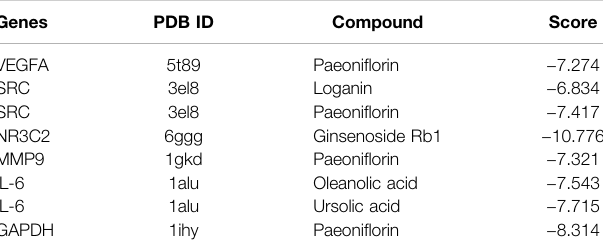
TABLE 2 | Molecular docking information